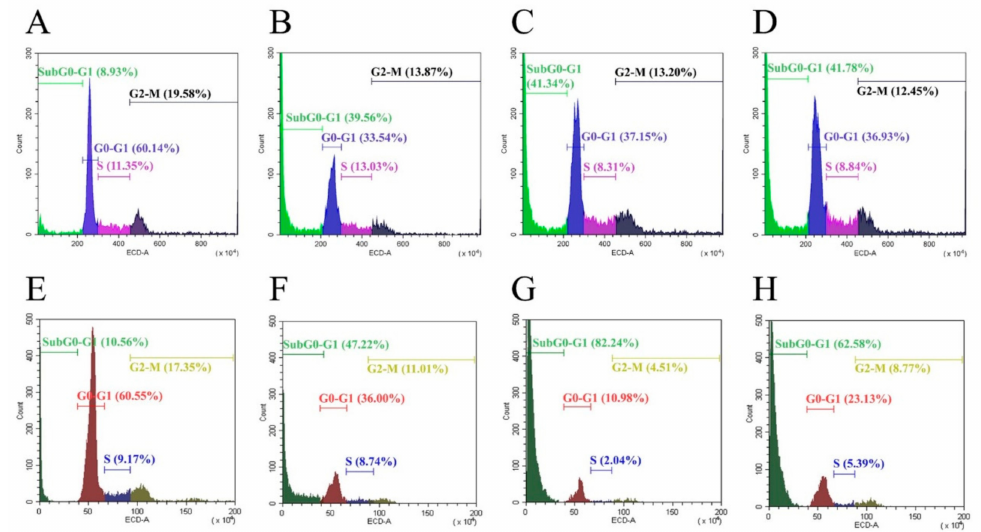
Figure 3. Representative cell cycle analyses. SW13 cells treated at 24 h: ( A ) Control; ( B ) EF24 6.5 µ M; ( C ) EF24 + mitotane; ( D ) mitotane 8 µ M. H295R cells treated at 72 h: ( E ) Control; ( F ) EF24 5 µ M; ( G ) EF24 + mitotane; ( H ) mitotane 10 µ M. Experiments were performed in